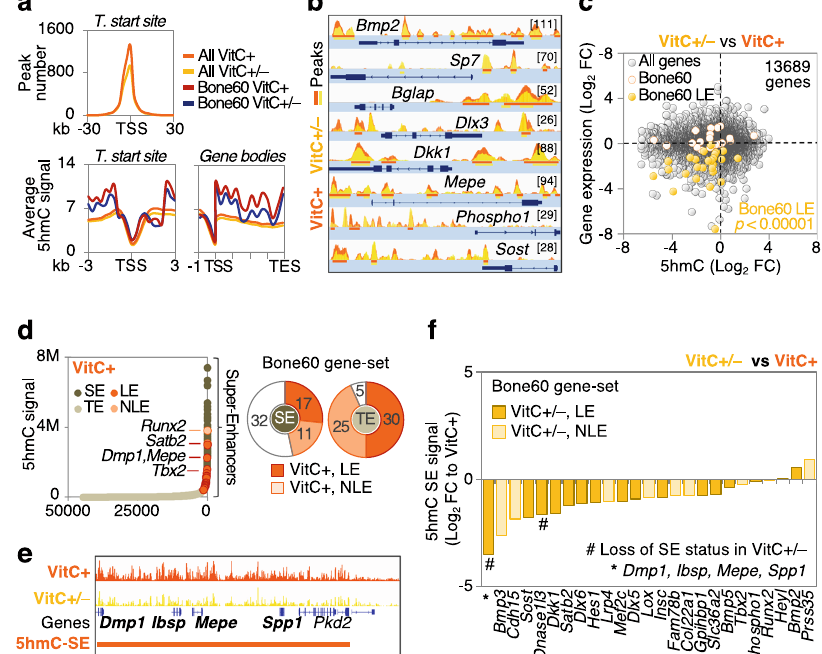
Fig.3|VitaminC-sensitiveDNAhydroxymethylationlevelsdistalandproximal to bone-speci fi c genescorrelatewiththeir expression.a hMeDIP-seqanalysis of femoral bone showing average 5hmC peak number around transcriptional start sites (TSS), average 5hmC signal around TSS or in gene bodies for all genes or for the Bone60 gene-set; TES, transcriptional end site. b Overlaid 5hmC peak occu- pancy comparing VitC+ and VitC ± groups near Bone60 genes in femurs; [value] =max peak scale. c Correlation between gene expression and 5hmC occupancy